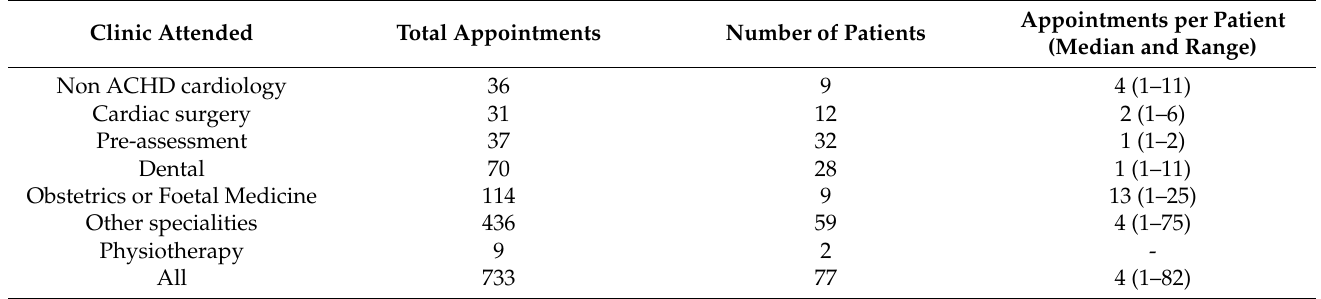
Table 3. Additional outpatient attendances during the study period (ACHD: Adult congenital heart